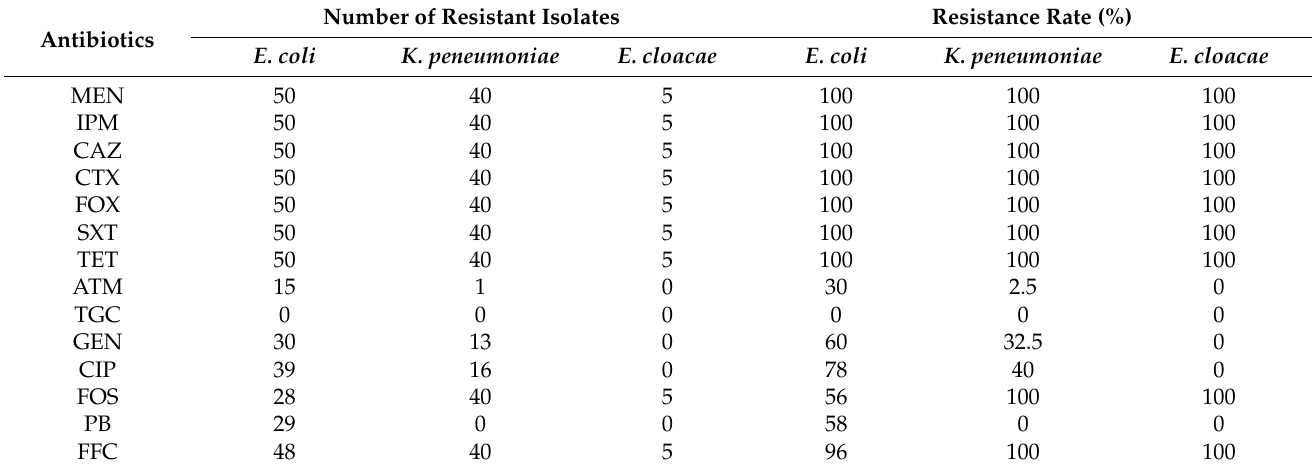
Figure 1. Antibiotic resistance genes (ARGs) and multilocus sequence typing (MLST) clustering of NDM-producing Enterobacterales . The species, STs, and antibiotic resistance genes (ARGs) were indicated by different colors. Table 1. Results for antibiotic resistance rate of the bla NDM gene carrying Enterobacterales .